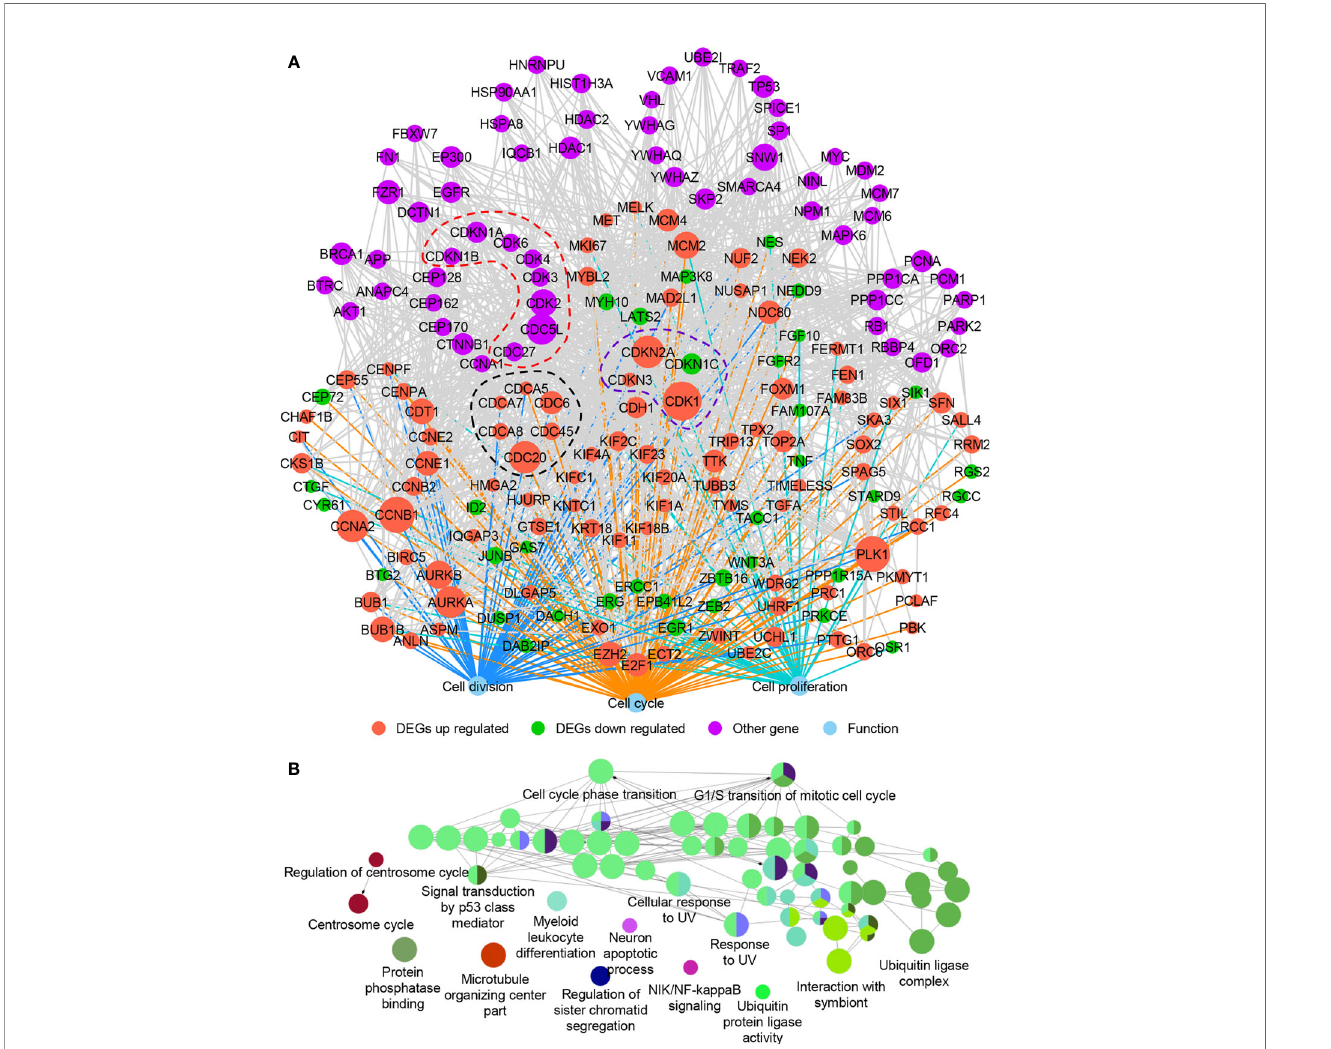
FIGURE 5 | The protein – protein interaction network of DEGs involved in cell cycle, cell division, and cell proliferation. (A) The protein – protein interaction network. (B) ClueGO functional annotation of 61 other genes (purple nodes in A ) that interacted with the up- and downregulated DEGs in (A) . A p -value of ≤ 0.01 was used, and experimental validated biological processes (BP), cellular components (CC), and molecular functions (MF) were